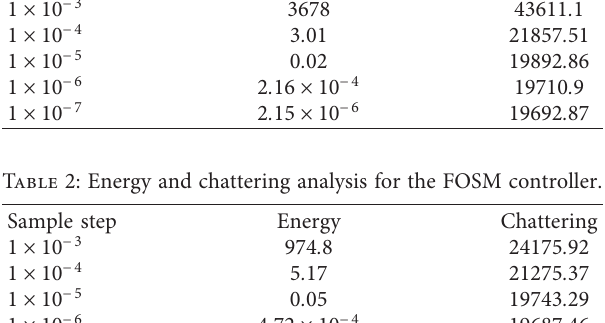
Table 1: Energy and chattering analysis for the SSTA controller. Sample step